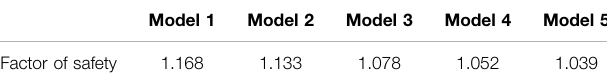
TABLE 4 | Slope safety coef fi cient in fi ve working conditions.